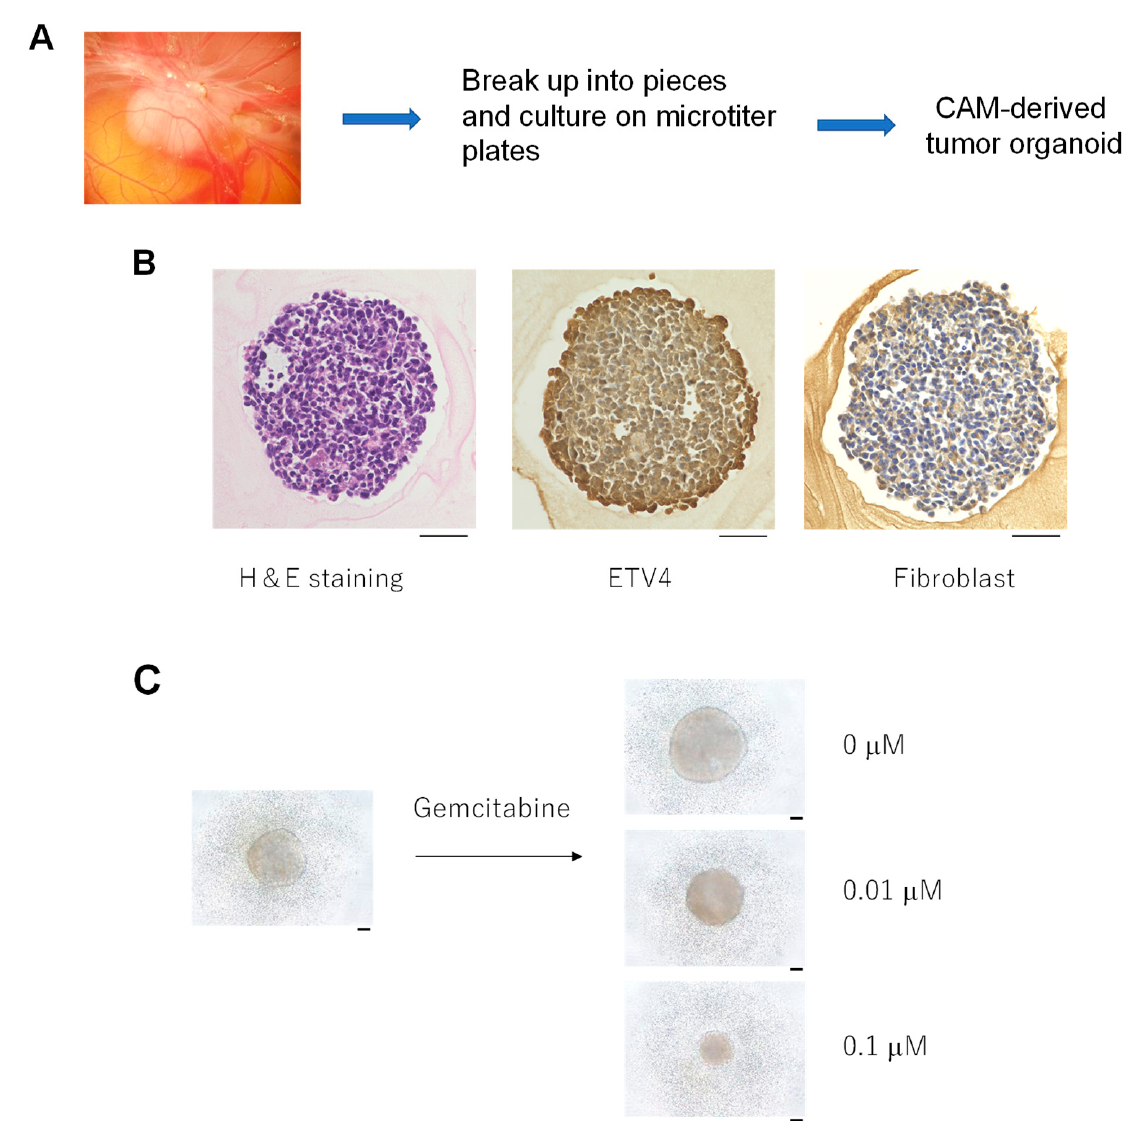
Figure 6. ( A ): CAM tumors can be broken up into pieces by physical and enzymatic methods. They can be cultured to form uniform sized organoids. ( B ): H&E staining and detection of ETV and fibroblasts. Scale bar represents 0.05 mm. ( C ): Sensitivity of CAM organoids to gemcitabine. Test was performed with the tumor organoids. Scale bar represents 0.1 mm.